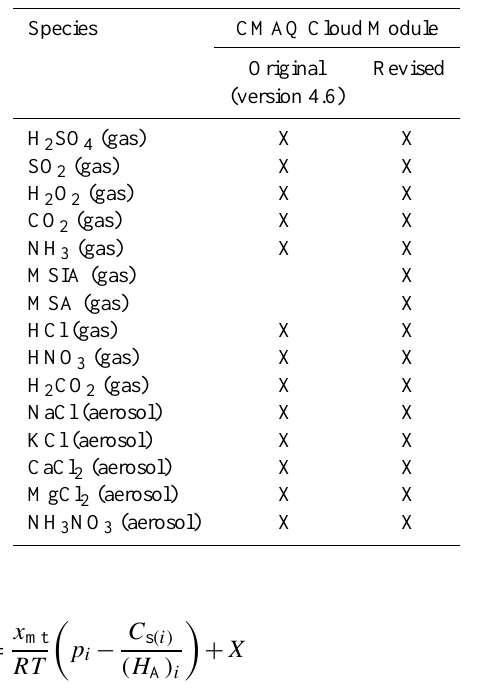
Table 5. Airborne chemical species ingested by clouds and used to compute droplet